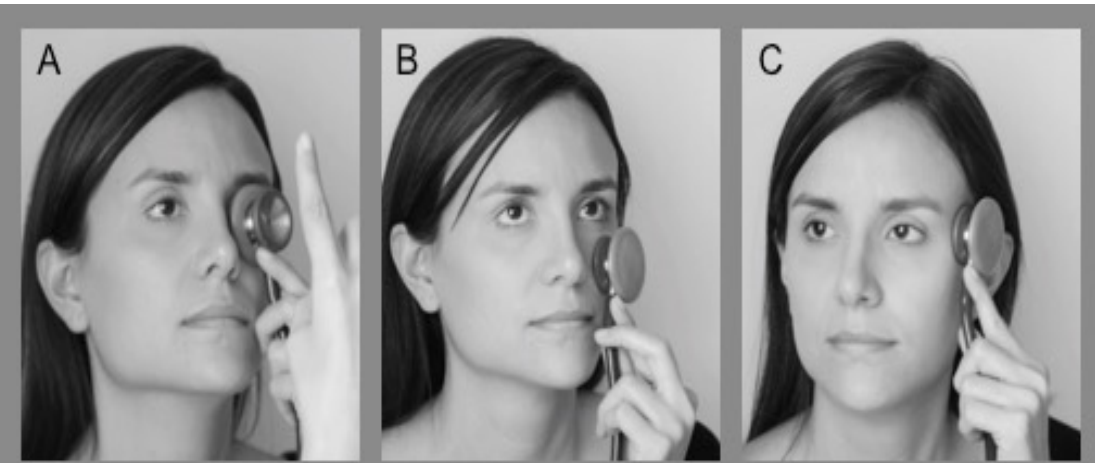
Figure 2. Adequate Technique for Ocular Auscultation. The bell of the stethoscope should be placed over the patient’s closed eye. The examiner’s finger can be used to keep the patient’s sight fixed and avoid eyelid tremor (A). Auscultation should include the zygomatic (B) and temporal regions